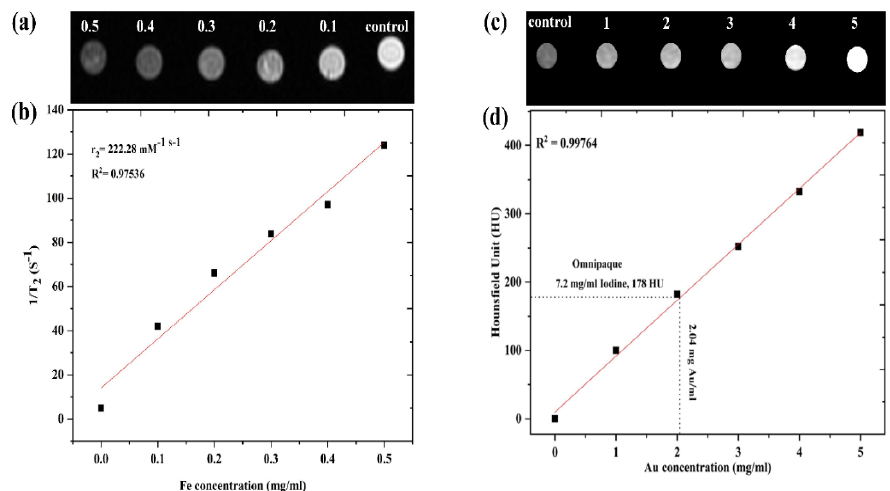
Figure 6. ( a ) MR images with various Fe doses; ( b ) T 2 linear fitting of Fe 3 O 4 @Au NPs; ( c ) CT images of various Au doses; and ( d ) the intensity of X-ray attenuation [63].